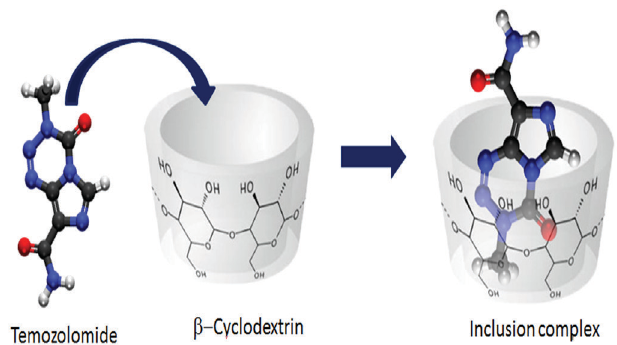
FIGURE 2 - Inclusion complex between TMZ and β